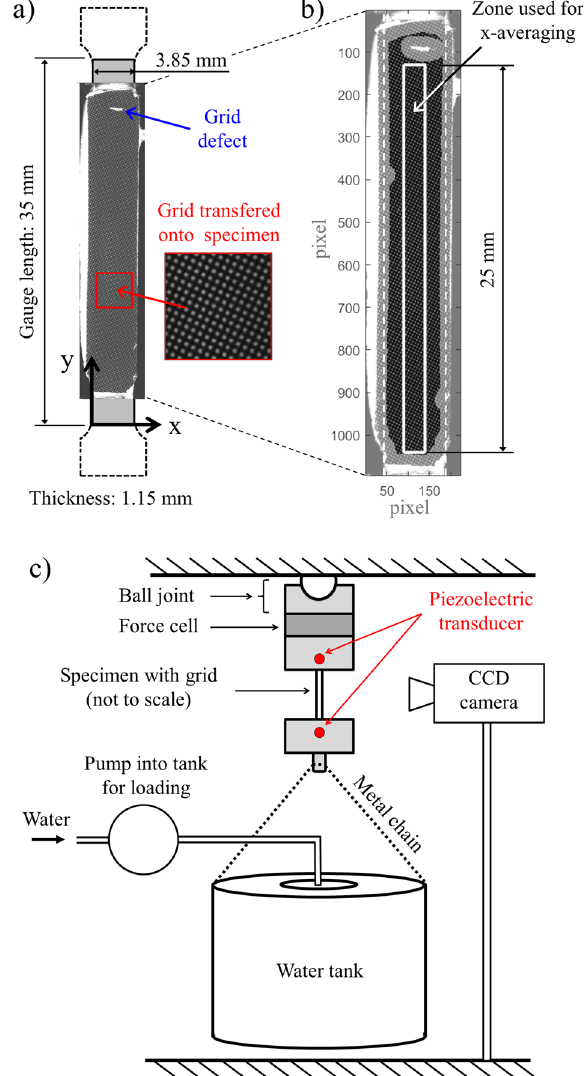
Fig. 1 Experimental setup. a Sketch of the CuZnAl single-crystal specimen (3.85 × 35 × 1.12 mm), with photograph of the grid transferred onto it. b Detail showing the rectangular strip (outlined in white) used to extract the 1D strain pro fi les along the vertical y -axis, by means of x -averaging of the 2D strain maps produced by the grid method. The white-dashed lines mark the specimen sides. The dark-shaded domain on the grid was used for 2D strain mapping to avoid side effects. c Schematic view of the loading device, showing the position of the piezoelectric transducers used for the 1D localisation, along the y -axis, of the acoustic